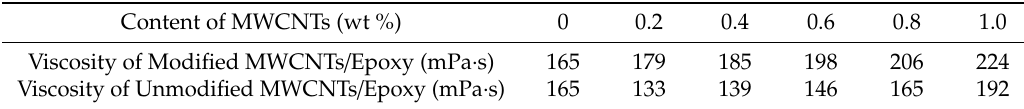
Table 2. Viscosity of the MWCNTs / epoxy resin mixture solution.